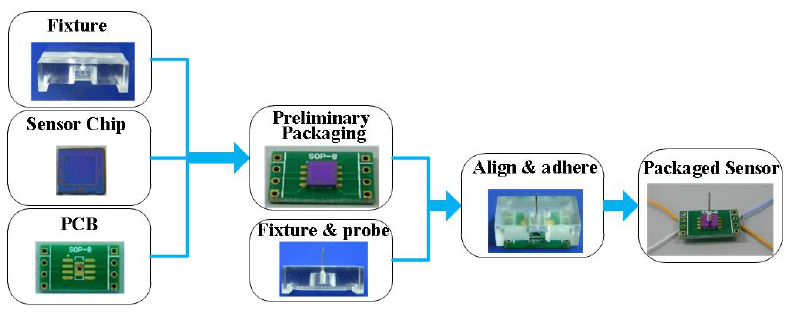
Figure 10. Package of the force sensor.